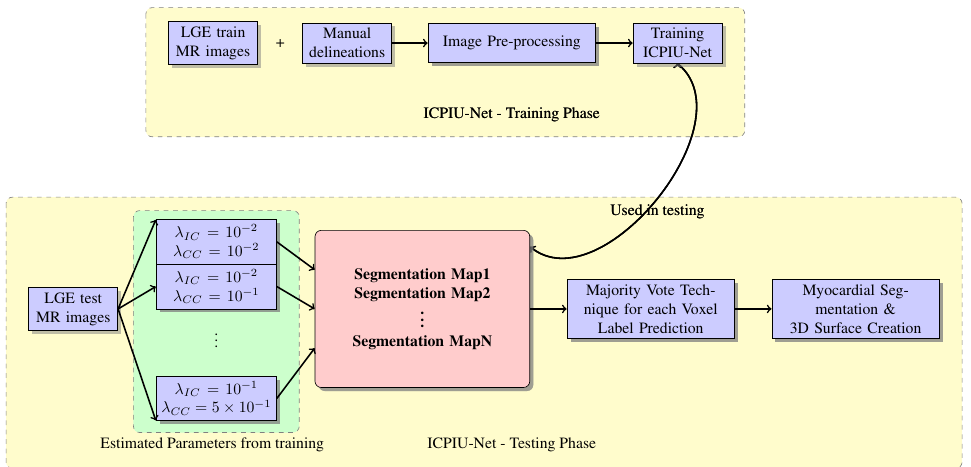
Figure 3. Block diagram of ICPIU-Net